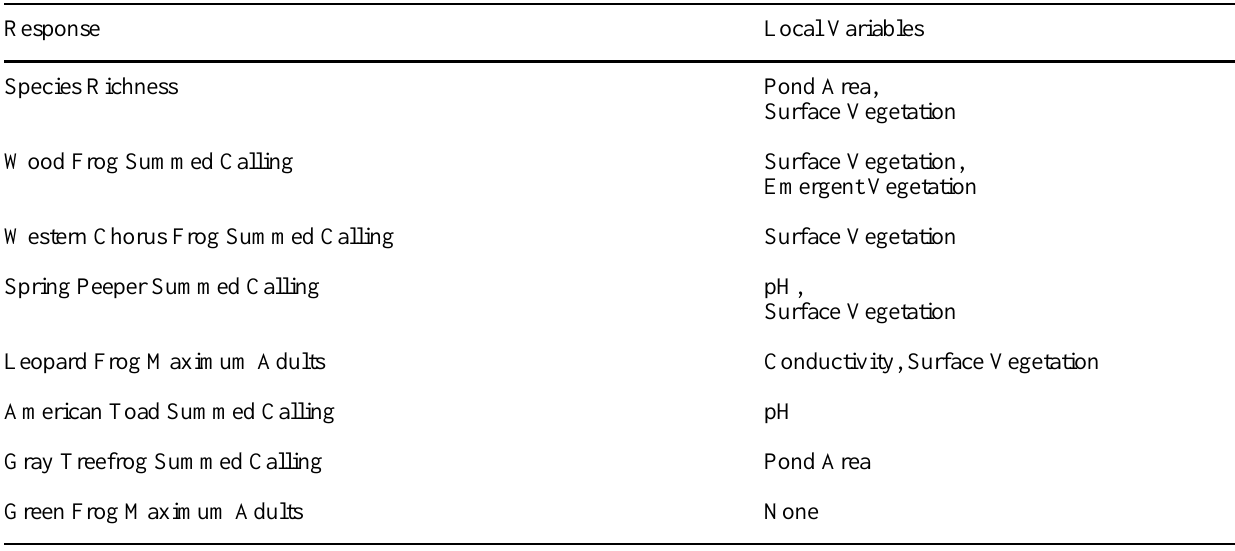
Table 3. Local pond variables included in both the linear and piecewise regression models. Only local variables that were present in the last step of a preliminary stepwise model selection procedure (stepAIC; Venables and Ripley 2002) that included all local pond variables as well as distance to Highway 401. We only included two local variables (surface vegetation and proportion of overhanging trees) and distance to the 401 in the stepwise model for the western chorus frog. See methods for